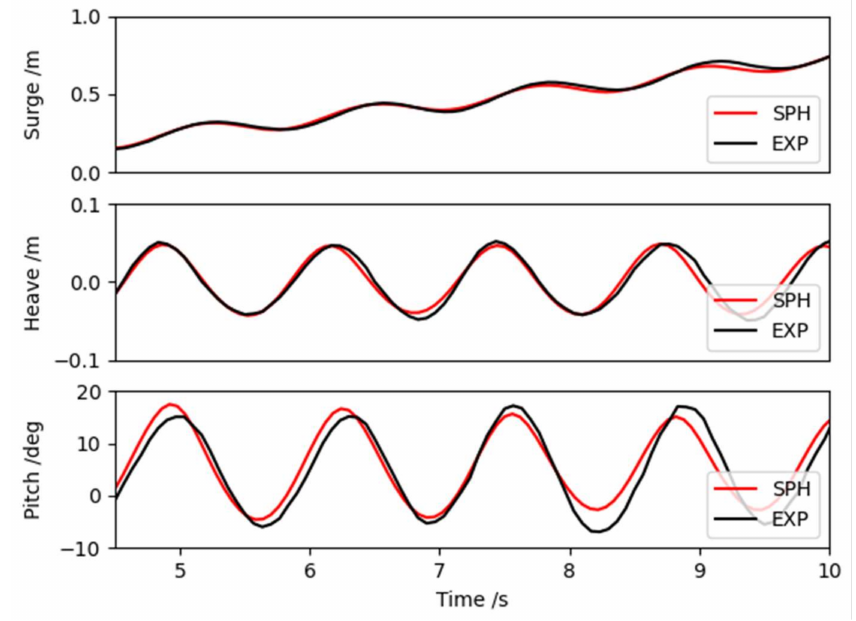
Figure 7. Comparison between experimental and numerical time series of the 3-DoF motions under a regular wave with H = 0.1 m and T = 1.2